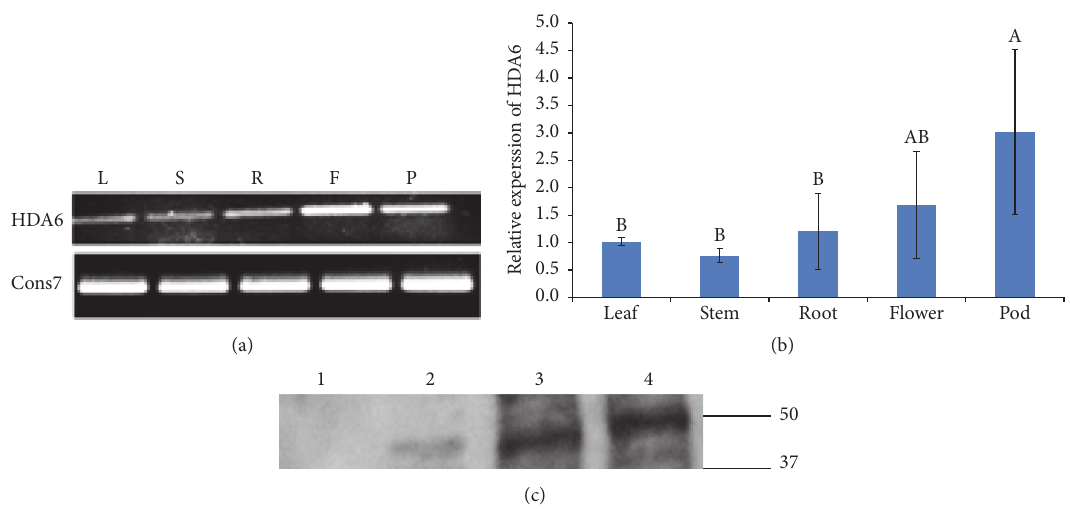
Figure 4: Spatial expression profile of HDA6 in five tissues of common bean. (a) Traditional PCR was conducted using HDA6 primers designed for qPCR. Each of the cDNA samples were normalized to 200 ng/ 𝜇 L. Regular PCR was conducted using HDA6 real-time primers designed for qPCR. The cons7 primer which is a constitutive gene was used as a control. (b) Determination of the relative expression of HDA6 transcript in different tissues of common bean by qPCR. The alphabets indicate significant difference between common bean tissues at 𝑝 < 0.05 . (c) Western blot analysis using HDA6 specific antibody with proteins isolated from empty pET vector (1) as a negative control, (2) leaf, (3) flower, and (4)